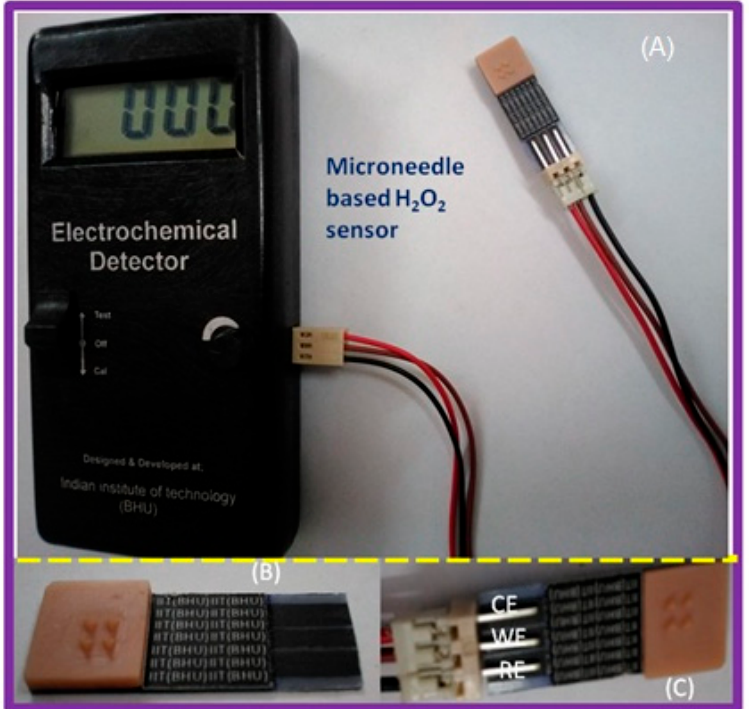
Figure 9. Construction of microneedle assembled screen-printed electrode (SPE)-based amperometric sensor for hydrogen peroxide. ( A ) Electrode assembly connected to a dedicated electrochemical detector; ( B ) Microneedle assembled SPE in three electrode configuration; ( C ) Electrode connector fixed to SPE: WE = working electrode, RE = reference electrode and CE = counter electrode) [26].